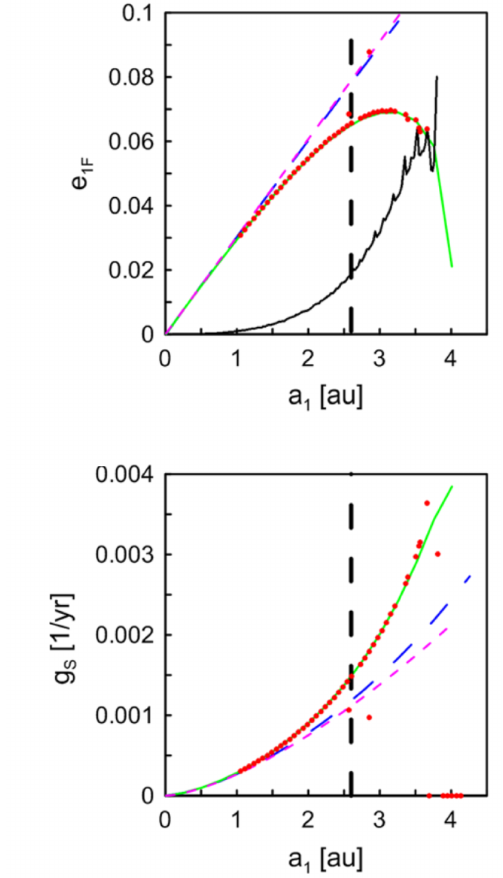
Figure 9. Figure taken from [88]. The values of e F (top panel) and g s (bottom panel) are computed for the planet in HD 196885 (the vertical dashed line shows its location). The red dots are reference outcomes of numerical simulations [7], the magenta curve is derived from [87], the blue curve from the first order model of [88] while the green curve is the second order model of [88]. The black curve shows the amplitude of the short period variations of the